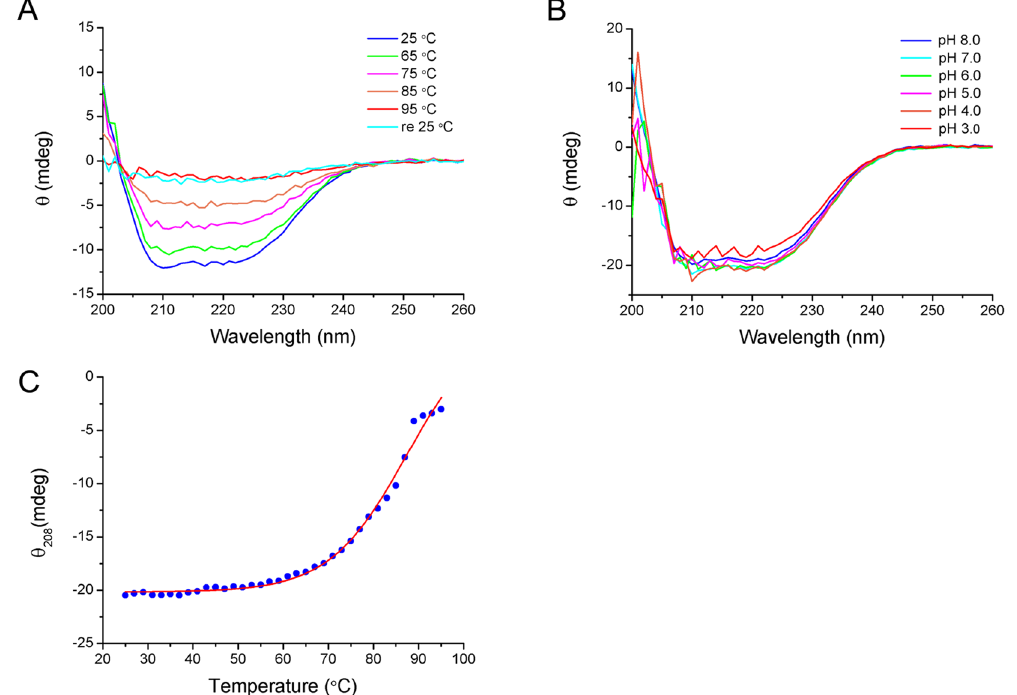
Figure 2. CD spectra of Sac-KARI in phosphate buffer (pH 8.0) containing 2 mM Mg 2 + . ( A ) The far-UV CD spectra of Sac-KARI measured over the wavelength range 200 to 260 nm at temperatures from 25 to 95 °C. ( B ) The far-UV CD spectra show that the secondary structure of Sac-KARI is unaffected by changes in pH over the range of pH values from 3.0 to 8.0. ( C ) CD-monitored thermal unfolding curve of Sac-KARI at 208 nm. Fitting of the thermal melting curve indicates that the Tm of Sac-KARI is approximately 86